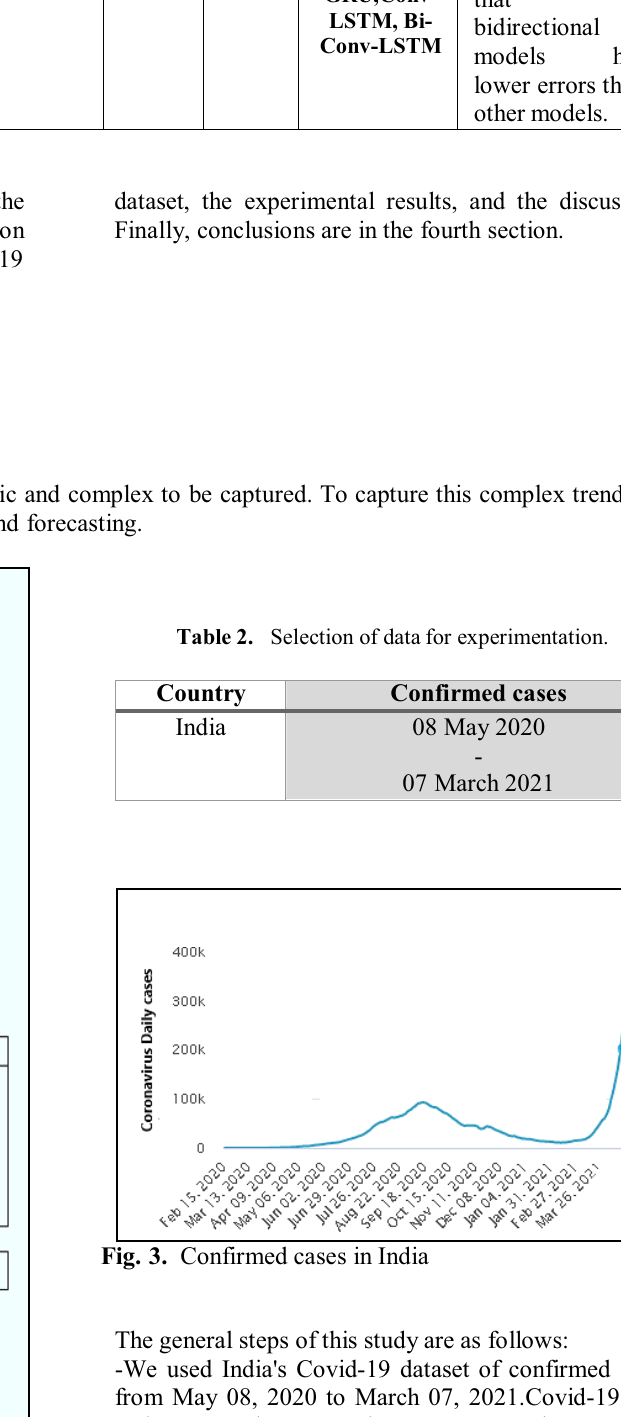
The general steps of this study are as follows: -We used India's Covid-19 dataset of confirmed cases from May 08, 2020 to March 07, 2021.Covid-19 time series data is accessed from https://data.covid19india.org/. The graphical representation of confirmed cases shows an increasing trend as shown in Figures